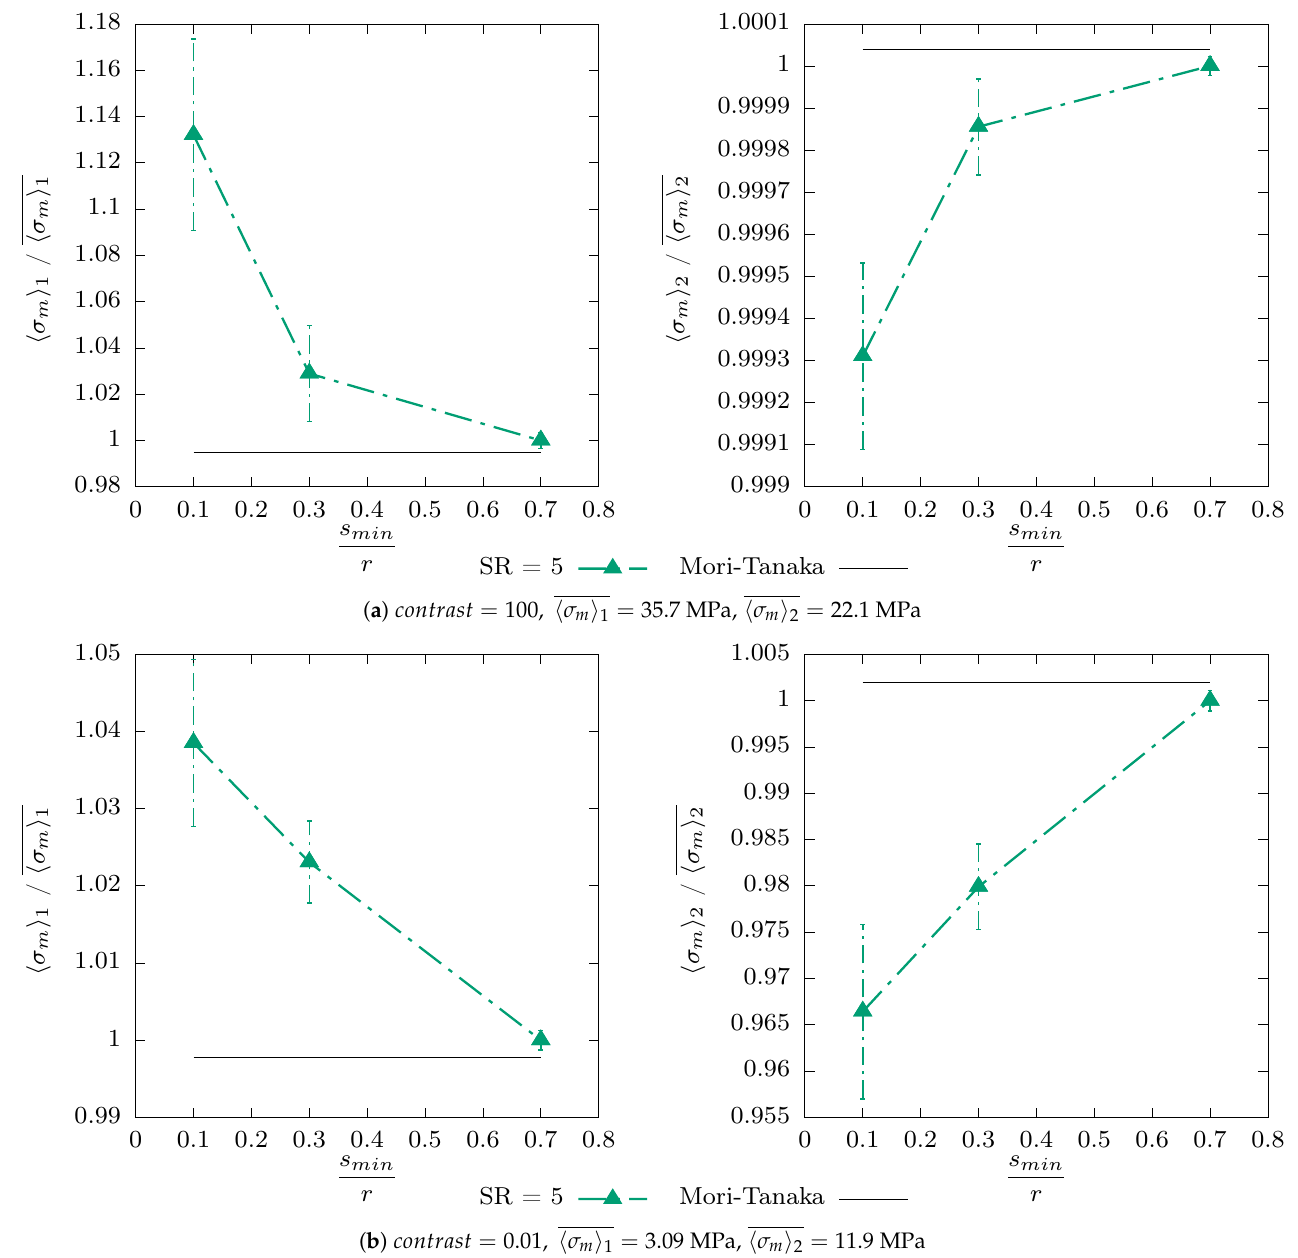
Figure A4. Mean values and standard deviations on the mean value for the first moment of hydro- static stress by phase as a function of the packing parameter s min / r ( r = 10 µ m) for a volume fraction of inclusions f v = 25.1